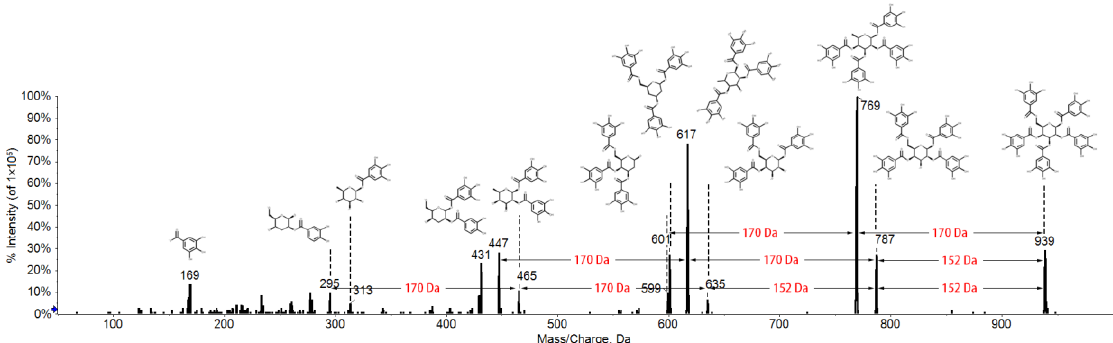
Figure 2. The fragmentation behavior of 1,2,3,4,6-penta- O -galloyl-beta- D -glucose (PGG).